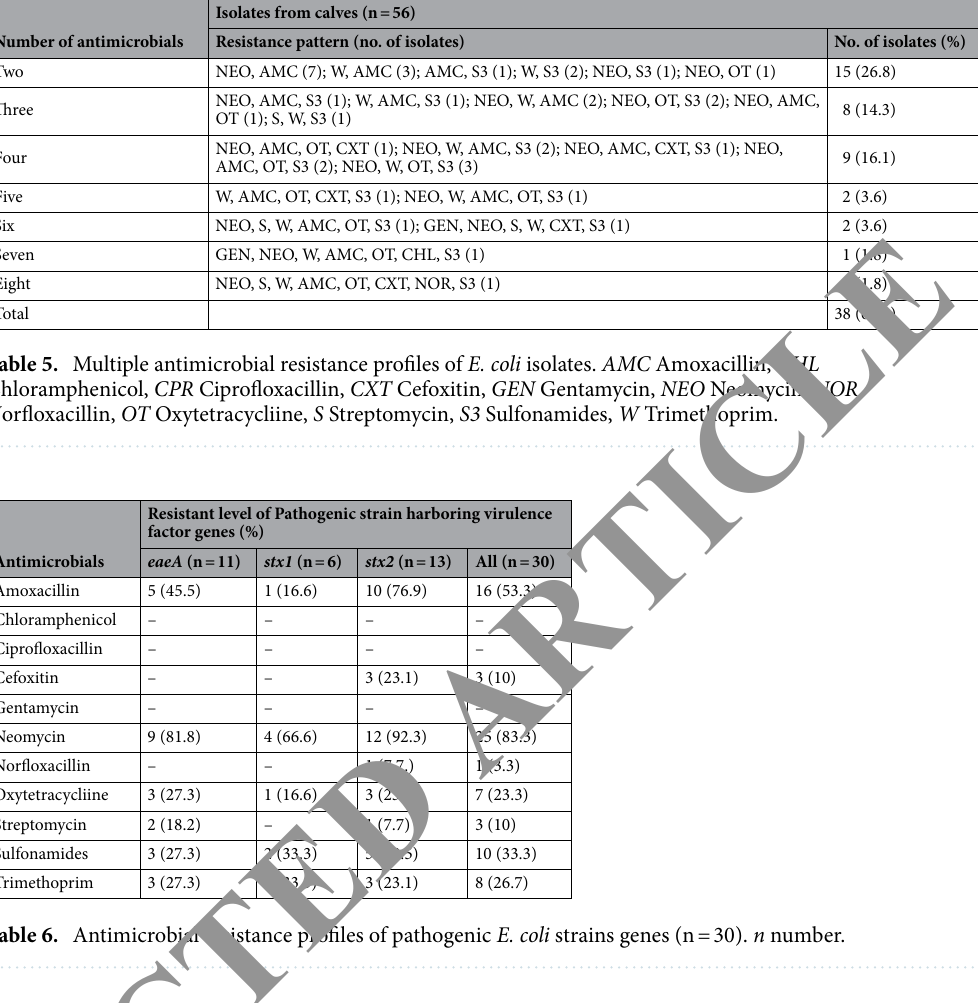
Table 6. Antimicrobial resistance profiles of pathogenic E. coli strains genes (n = 30). n number.